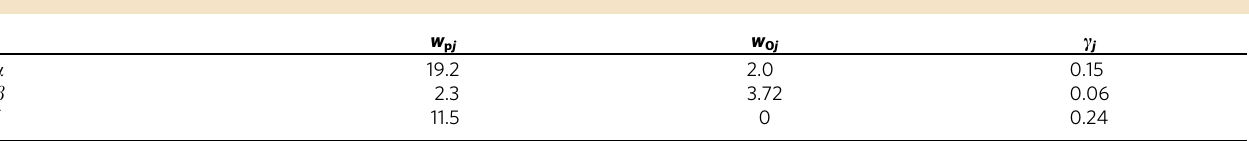
Thevalues given are in THz and were measured at 6K (ref. 25). The a and b phonons are represented by Lorentz terms. The Drude term is due to free bulk charge carriers ( f ) and not surface electrons, which we treat quantum